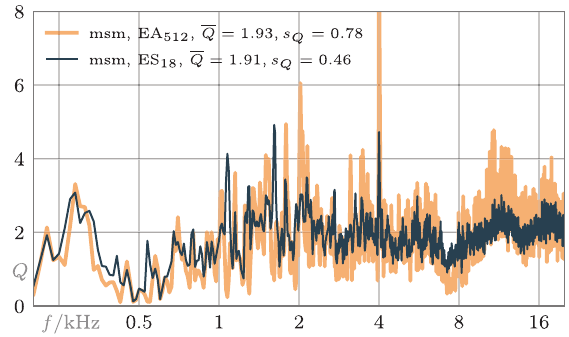
Figure 18. Directivity factor of the measured